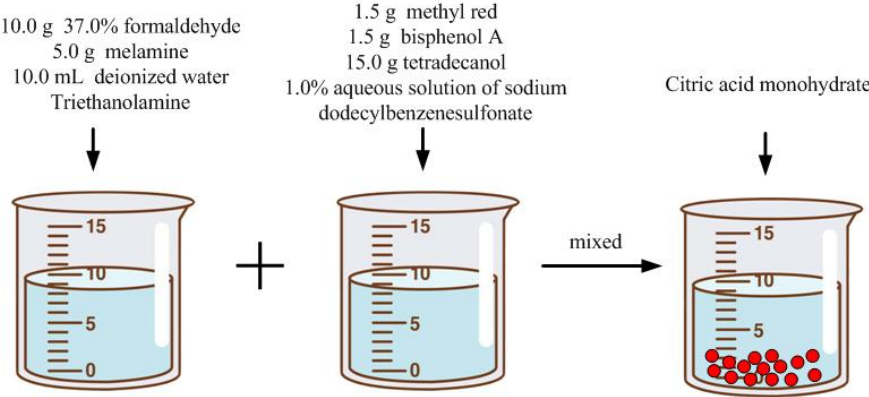
Figure 1. Schematic diagram of the preparation of color-changing microcapsules.